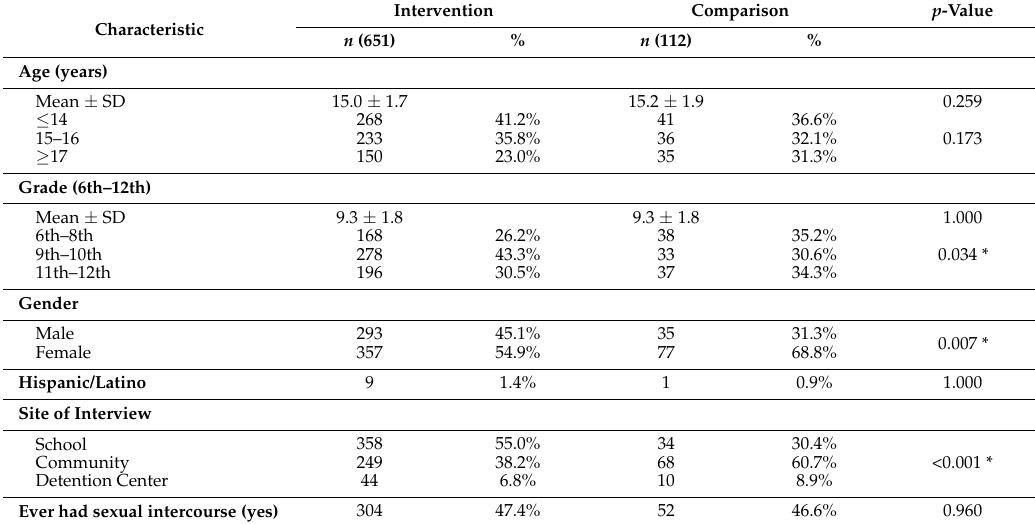
Table 2. Demographic characteristics of intervention and comparison groups at